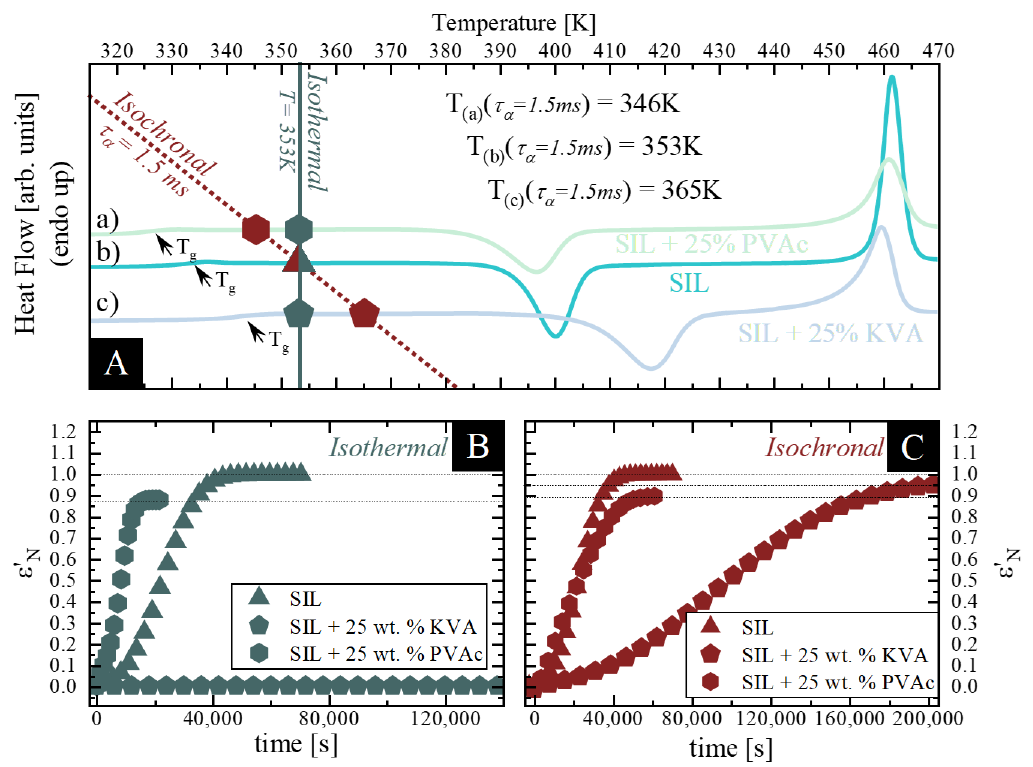
Figure 7. A presents the thermograms of a) SIL + 25 wt.% PVAc (sage); b) SIL (aqua) and c) SIL + 25 wt.% KVA (celeste blue). Wine hexagon, triangle and pentagon correspond to the temperatures at which the relaxation time of SIL + 25 wt.% PVAc (T = 346 K), SIL (T = 353 K) and SIL + 25 wt.% KVA (T = 365 K), respectively, is equal to τ α = 1.5ms. Slate hexagon, triangle and pentagon correspond to the points of the SIL + 25 wt.% PVAc; SIL and SIL + 25 wt.% KVA samples at 353 K. B shows the isothermal crystallization of SIL, SIL + 25 wt.% PVAc and SIL + 25 wt.% KVA as slate triangle, hexagon and pentagon, respectively. C shows the isochronal ( τ α = 1.5ms) crystallization of SIL (at T = 353K), SIL + 25 wt.% PVAc (at T = 346 K) and SIL + 25 wt.% KVA (at T = 365 K), as wine triangle, hexagon